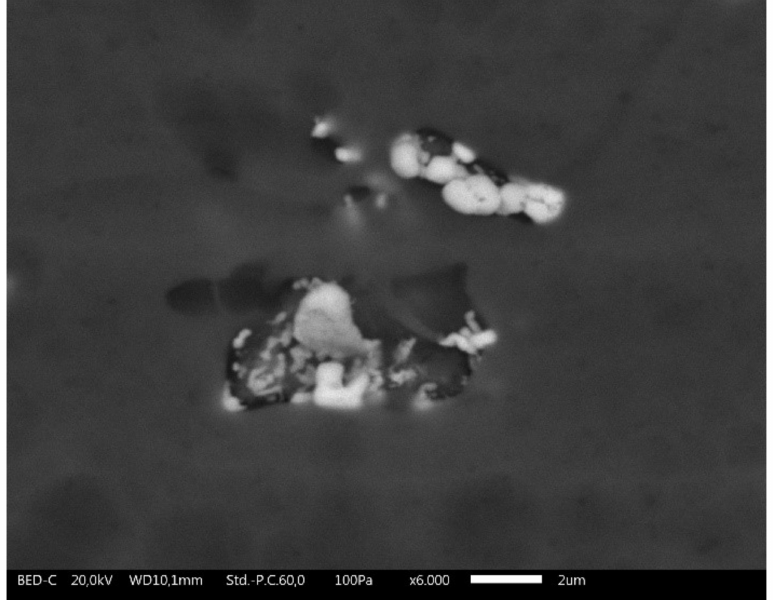
Figure 2. SEM observation of silver powder entrapped in the alumina layer of sample A. The three series of samples possess similar surface morphology: the alumina layers reveal different localized cavities, with diameters between 1 and 7 µ m, able to host the silver during the deposition process. The increase in silver nitrate added to the anodizing bath causes a rise in the concentration of silver detected in the alumina film, as shown in Figure 3, captured with SEM. The white traces visible in (b) and (c) represent the silver powder, whose high atomic weight favours its observation in backscattered mode. The presence of silver increases from sample A (b) to sample B (c), as confirmed by the EDXS analyses, which show a silver element concentration ranging from 0.73 to 1.57 wt.%, respectively. Figure 3d represents the EDXS map of the silver element relative to the area observed in Figure 3c, confirming the high amount of silver powder introduced into the alumina